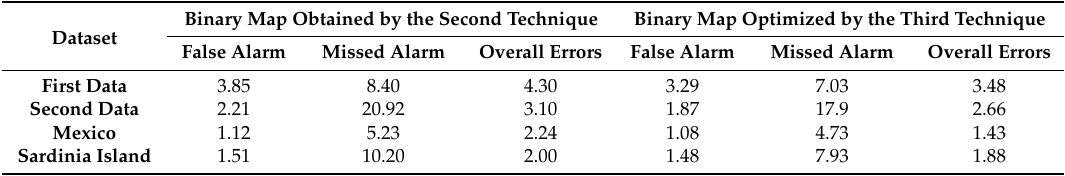
Table 5. Quantitative Comparison (%) between the Second and Third Techniques on the Four Datasets.